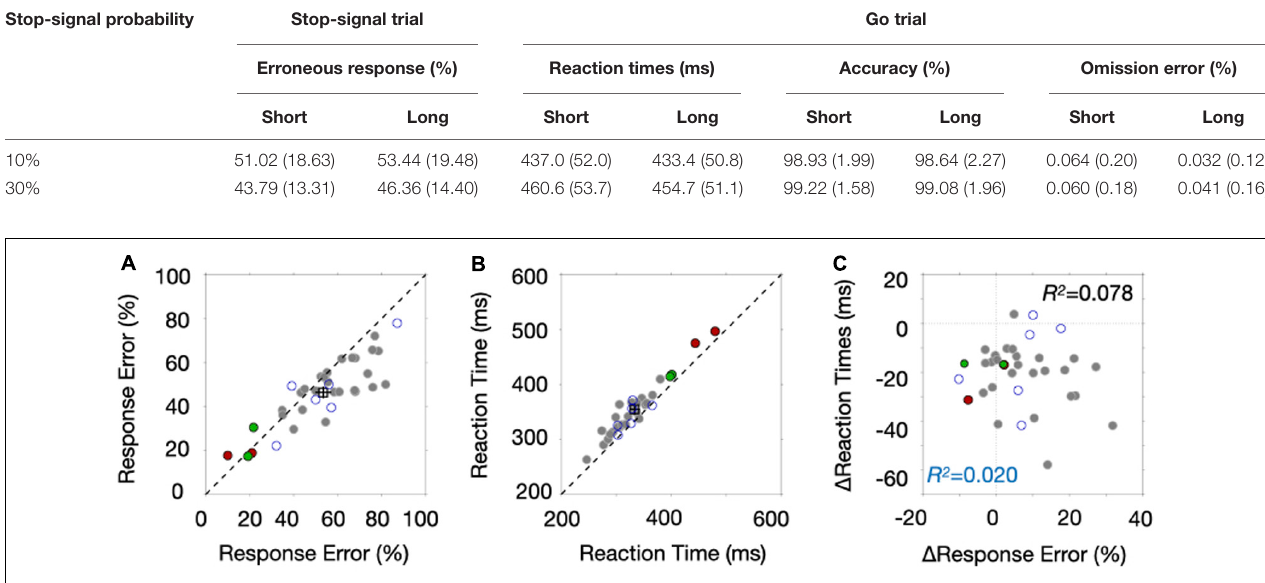
FIGURE 2 | Behavioral results. (A) The proportion of response errors of the high probability block is plotted as a function of response errors of the low probability block. Each data point corresponds to the mean response probability of each participant. The square marker is the average, and the error bars indicate ± SEM (standard error of the mean). The red filled circles and blue open circles indicate data points excluded from the ERP analysis due to their waiting strategy and noisy ERPs, respectively. The green boundary circles were included in the analysis. (B) Response times of the high probability block are plotted as a function of response times of the low probability block. Other aspects are the same as those in Figure 2A . (C) Reaction time difference between the two probability conditions is plotted as a function of the difference in response errors of the stop-signal trials.